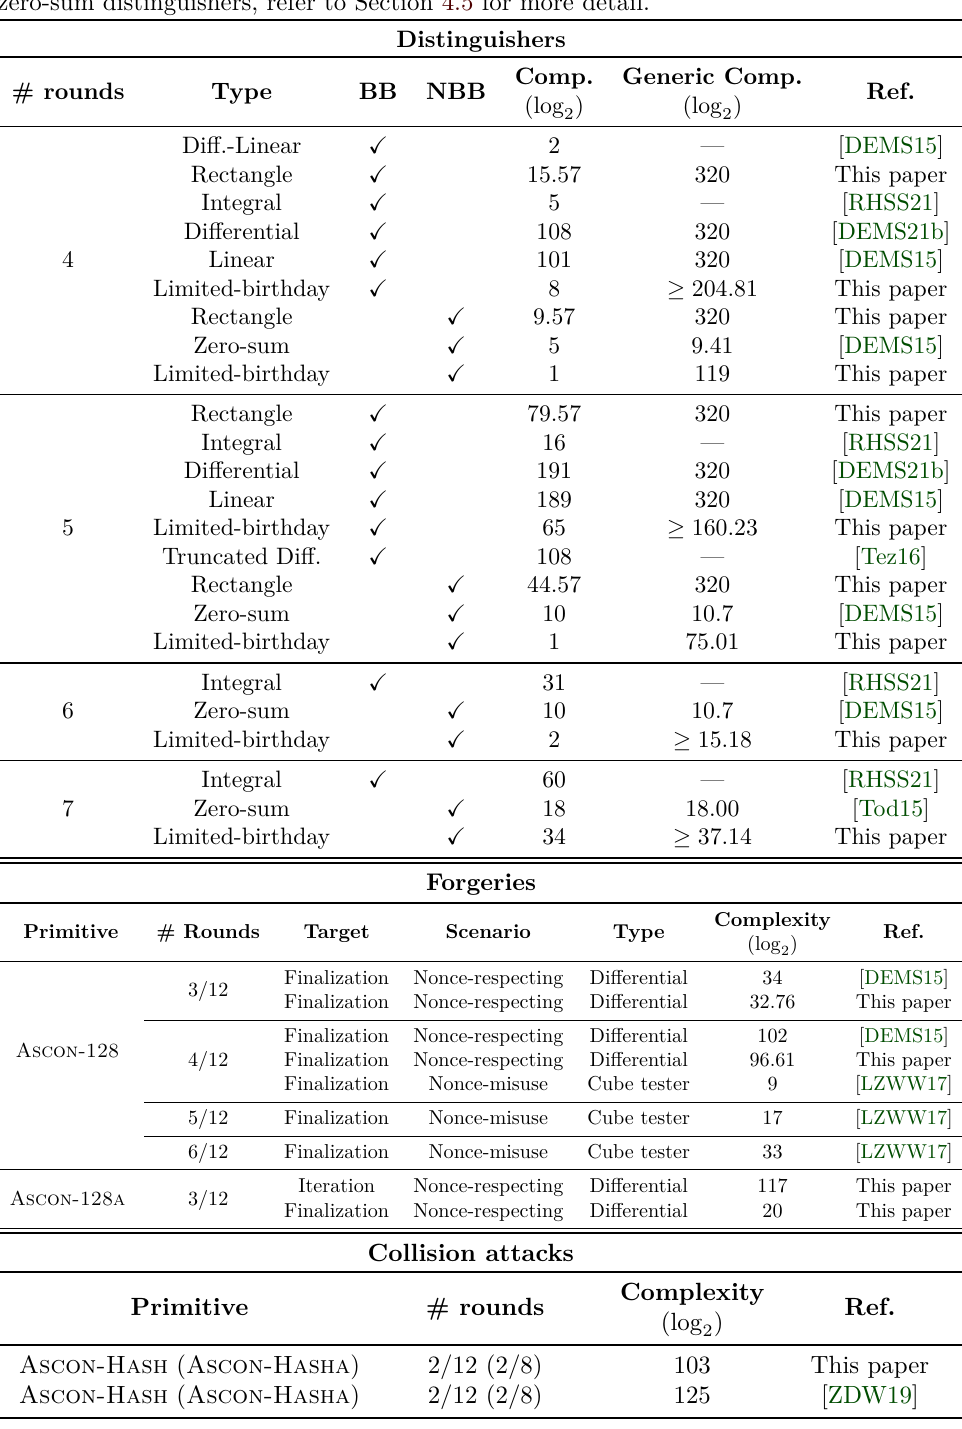
Table 1: Summary of results on permutation and attacks on reduced-round Ascon-128 , Ascon-128a and Ascon-Hash ( Ascon-Hasha ). Complexities are expressed in number of primitive calls. BB and NBB represent black-box and non-black-box distinguishers. Note that Ascon-128 , Ascon-128a , Ascon-Hash and Ascon-Hasha use 6, 8, 12 and 8 rounds of permutation in the iteration phase respectively. All of the primitives use 12 rounds for the initialization and finalization (if applicable). For generic complexity on zero-sum distinguishers, refer to Section 4.5 for more